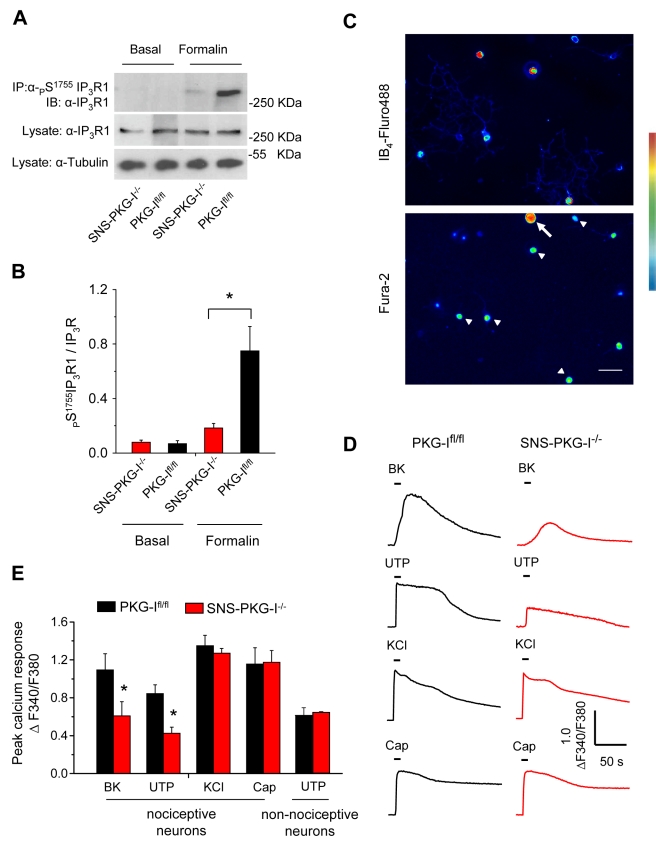
PKG-I mediates nociceptive activity-dependent phosphorylation of Inositol 1,4,5-triphosphate receptor 1 (IP3R1) in DRG and potentiates evoked calcium transients.(A, B) Typical examples (A) and quantitative summary (B) of levels of immunoprecipitated IP3R1 phosphorylated at serine 1755 or total IP3R1 in L4-L5 DRG lysates derived from naïve or formalin-injected PKG-Ifl/fl and SNS-PKG-I−/− mice. (C–E) Comparison of evoked calcium transients in DRG neurons in culture derived from SNS-PKG-I−/− mice or their control PKG-Ifl/fl littermates. (c) Typical examples of Fura2-loaded dissociated DRG neurons, which were co-stained with Fluor 488-conjugated isolectin B4 (IB4) to identify non-peptidergic nociceptive neurons (arrowheads). (D) Typical examples of traces of calcium transients evoked by bath application of bradykinin (BK, 50 nM), UTP (100 µM), KCl (25 mM), and capsaicin (1 µM) in IB4- and Fura2-double-labelled DRG neurons from PKG-Ifl/fl and SNS-PKG-I−/− mice. (E) Ratiometric Fura2-based imaging of calcium released upon bath application of bradykinin (BK, 50 nM), UTP (100 µM), KCl (25 mM), and capsaicin (1 µM) in IB4- and Fura2-double-labelled nociceptive DRG neurons from PKG-Ifl/fl and SNS-PKG-I−/− mice (9–10 independent culture experiments). Note that UTP-induced transients in non-nociceptive large-diameter neurons (e.g., arrow in panel C) are not different across genotypes. * p<0.05, ANOVA of random measures followed by post hoc Fisher's test. Scale bar represents 20 µm in panel C.